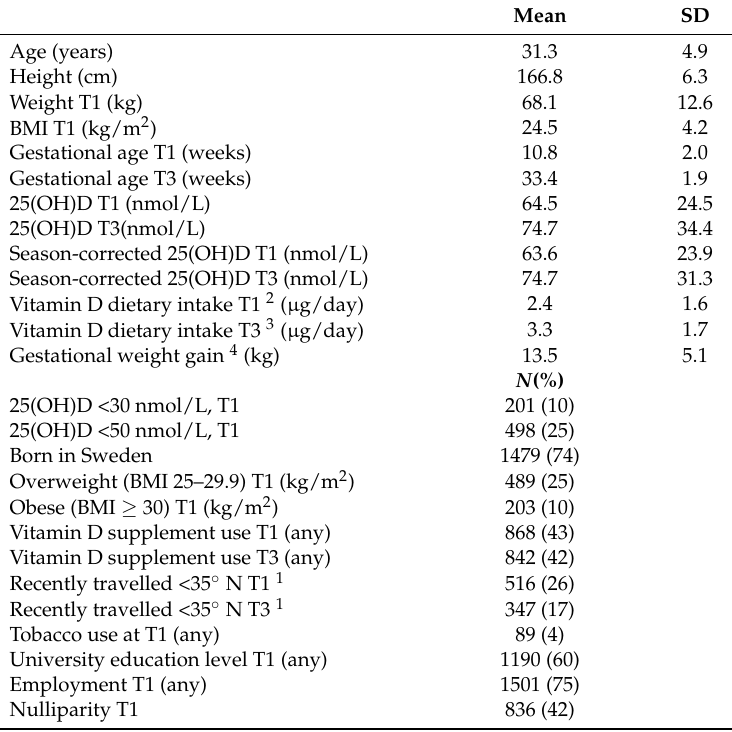
Table 1. Characteristics of the study